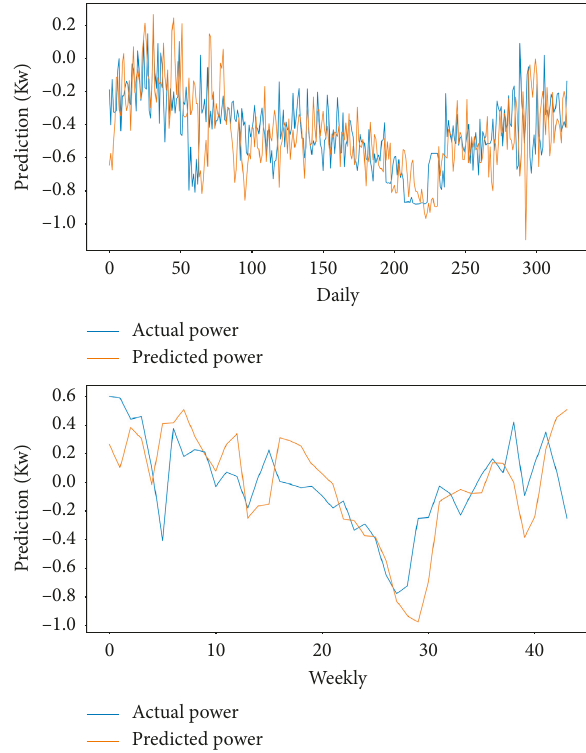
Figure 11: Forecasting results obtained using the proposed method for the household power dataset considering minute and hour time horizons.